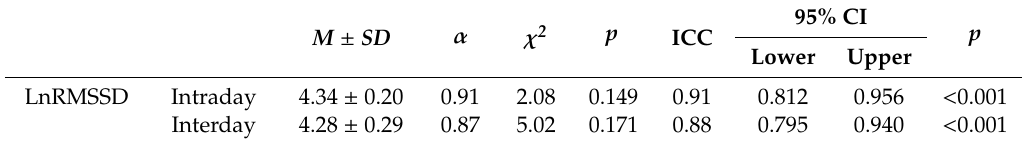
Table 3. Intraday and interday reliability of PPG-derived LnRMSSD